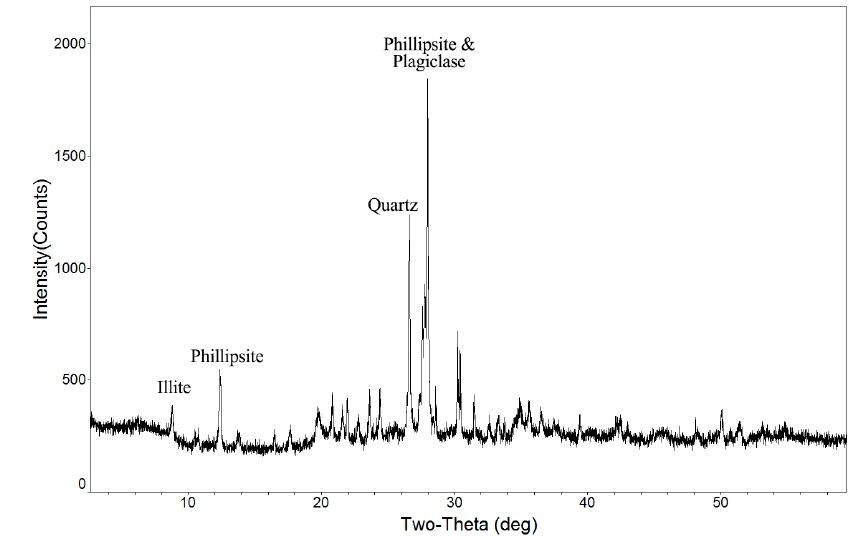
Figure 3. Representative XRD pattern of one bulk sediment sample from the Gagua Ridge. Quartz, plagioclase, phillipsite, and illite can be identified in the diagram.